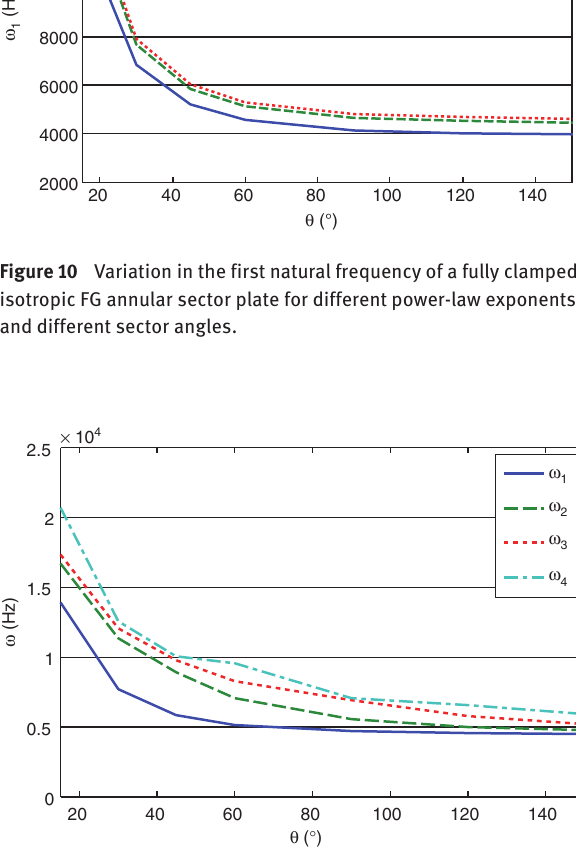
Figure 11 Variation in the first four natural frequencies of a fully clamped isotropic FG annular sector plate for n = 3 and different sector